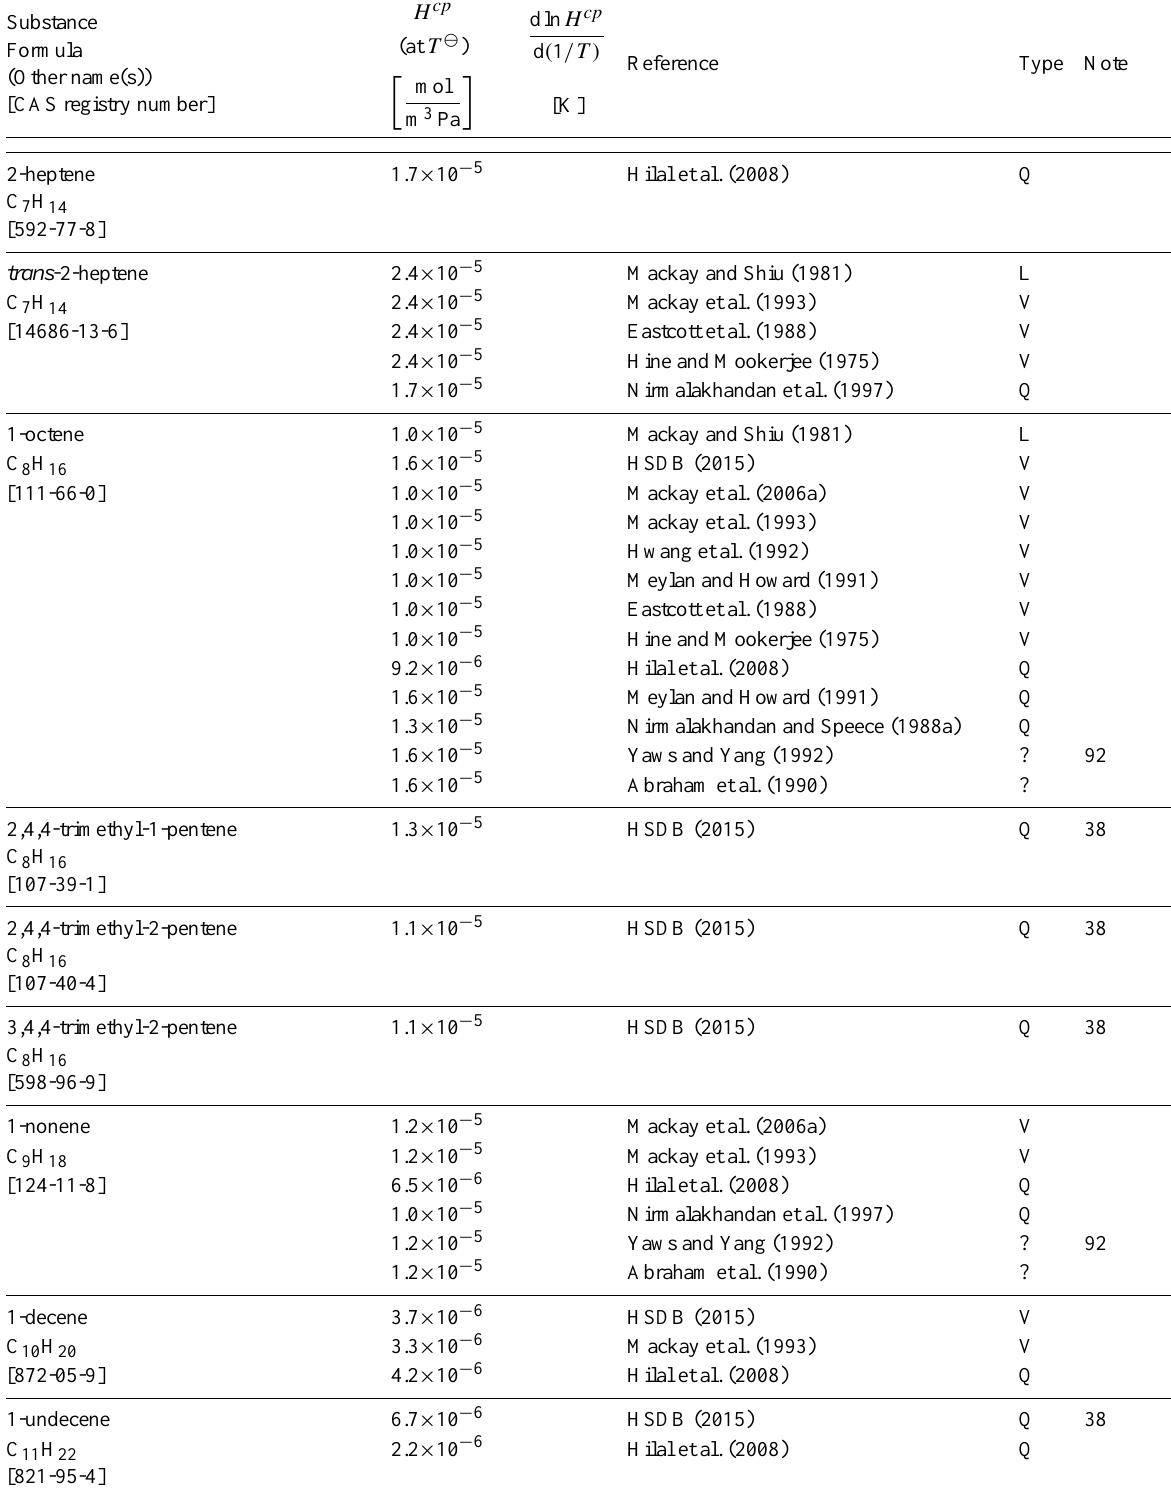
Table 6: Henry’s law constants for water as solvent